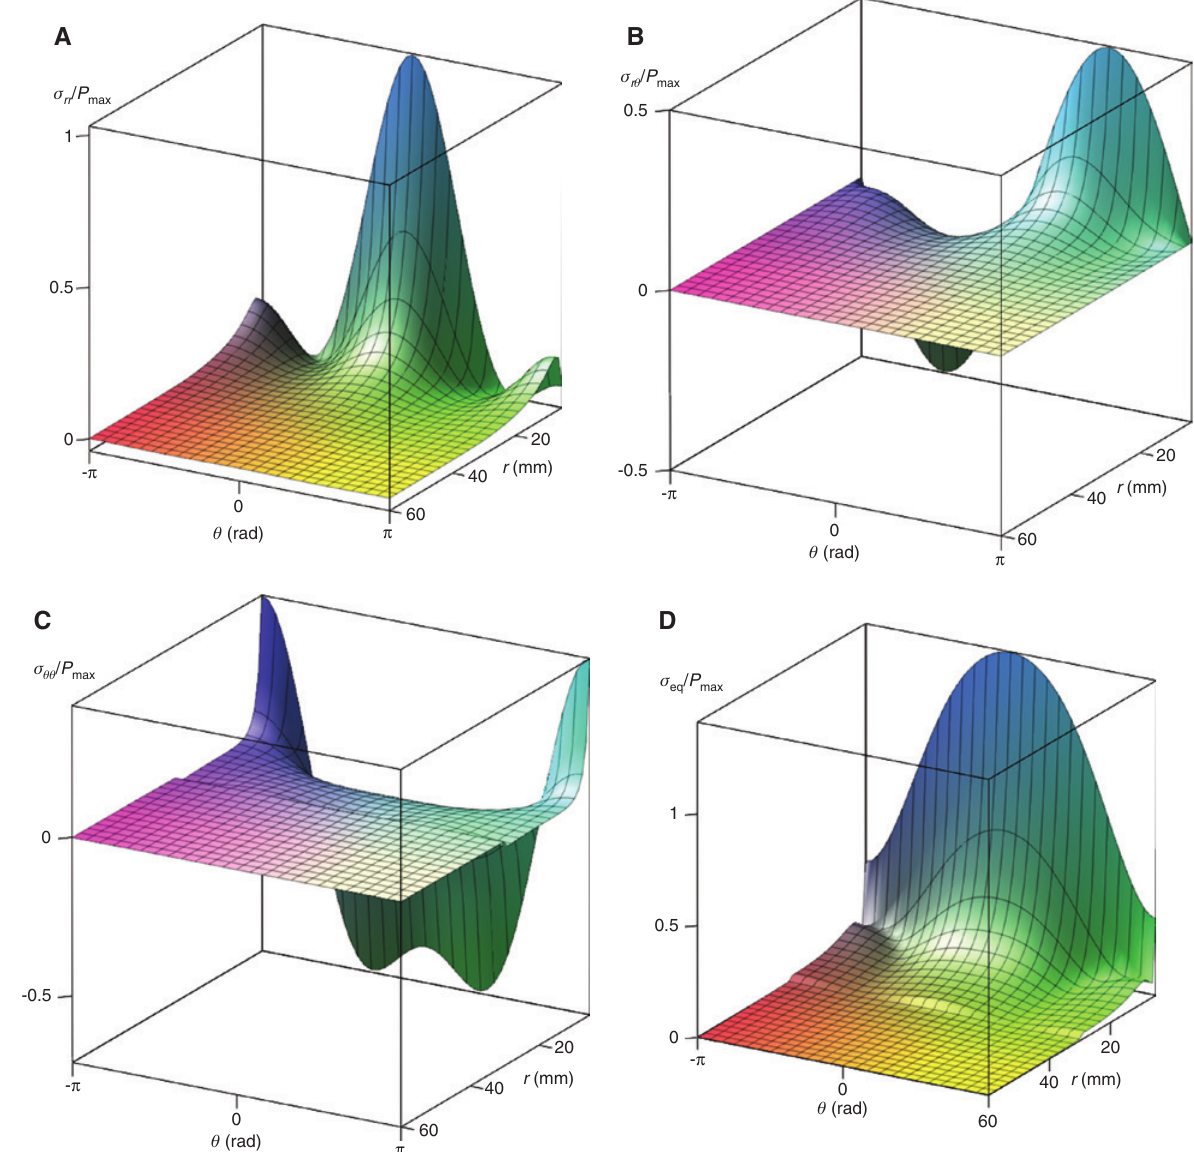
Figure 7: The near-field non-dimensional stress profiles of the conventional joint under half-cosine loading: (A) radial stress profile, (B) shear stress profile, (C) hoop stress profile, and (D) equivalent stress